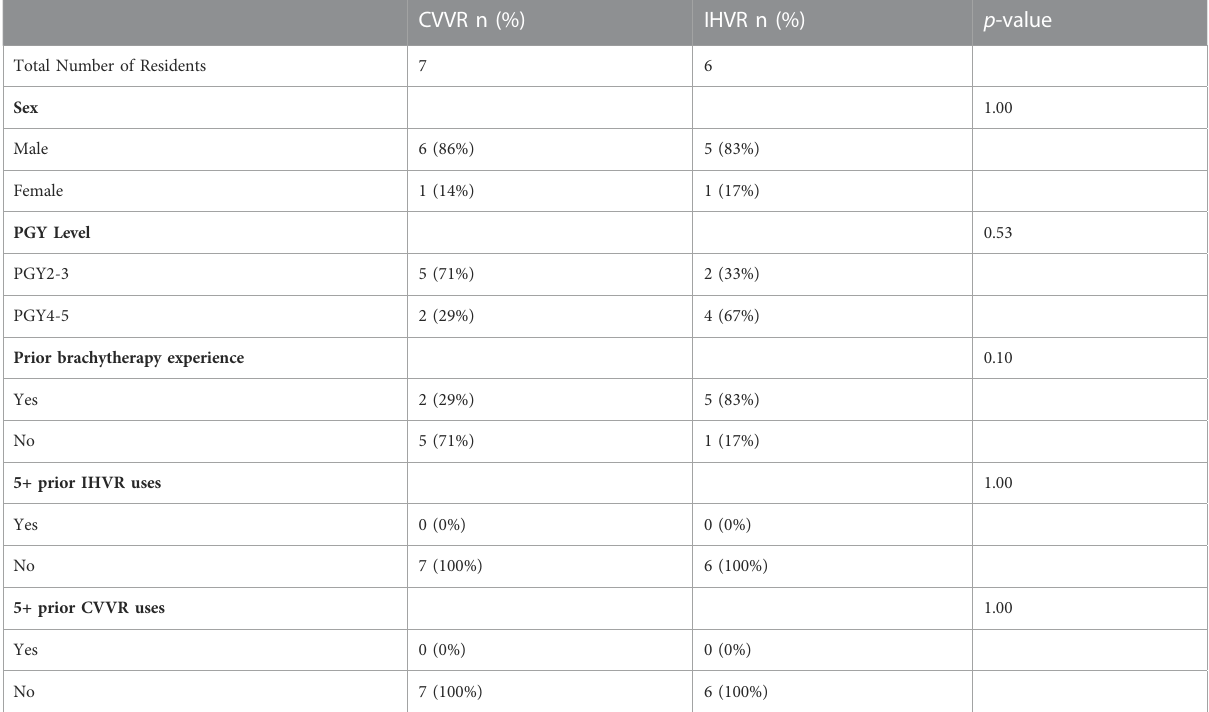
TABLE 1 Baseline Data on VR